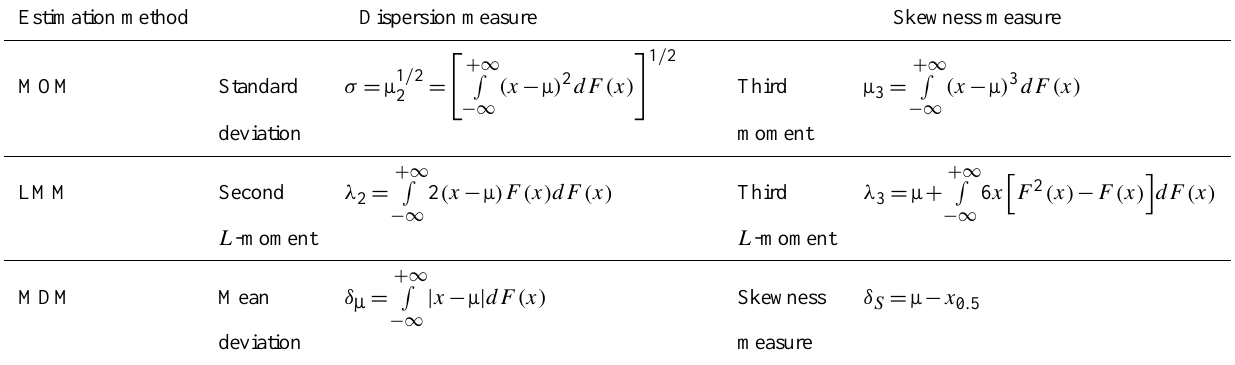
Table 1. Dispersion and skewness